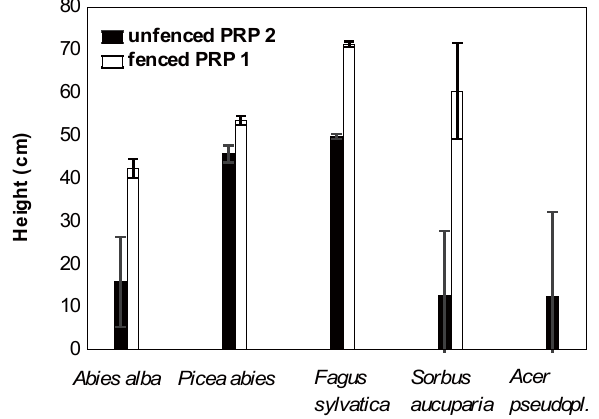
Figure 5. Mean height of recruits of particular tree species on PRPs 1 and 2 with 0.95 reliability